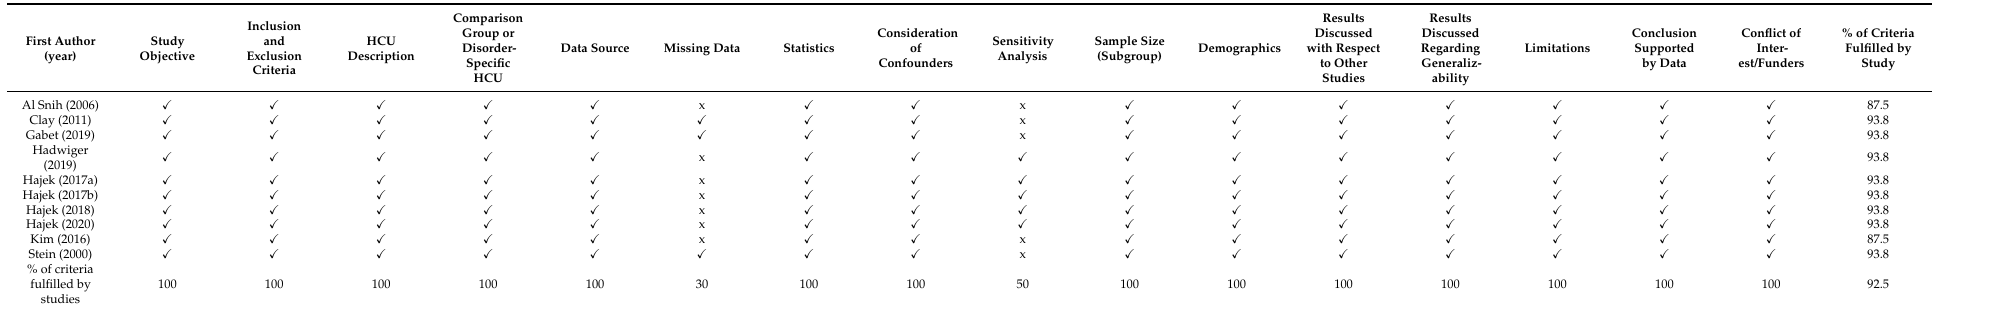
Table 3. Quality assessment of studies included in the systematic